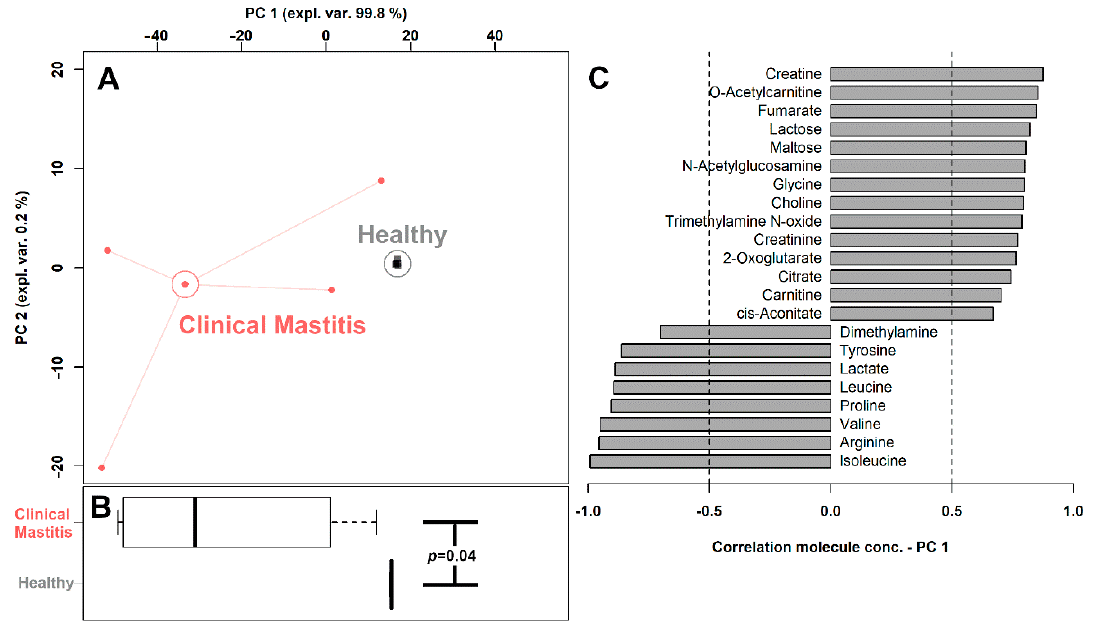
Figure 2. rPCA model built on the concentration of the molecules which showed a statistically significant difference between the two groups. In the score-plot ( A ), samples from the two groups are represented with squares (Healthy) and circles (Clinical Mastitis). The wide, empty circles represent the median of each samples’ group. The position of the samples along PC1 is summarized in the boxplot ( B) . The loading plot ( C ) reports the significant correlations ( p < 0.05) between the concentration of each substance and its importance over PC 1.